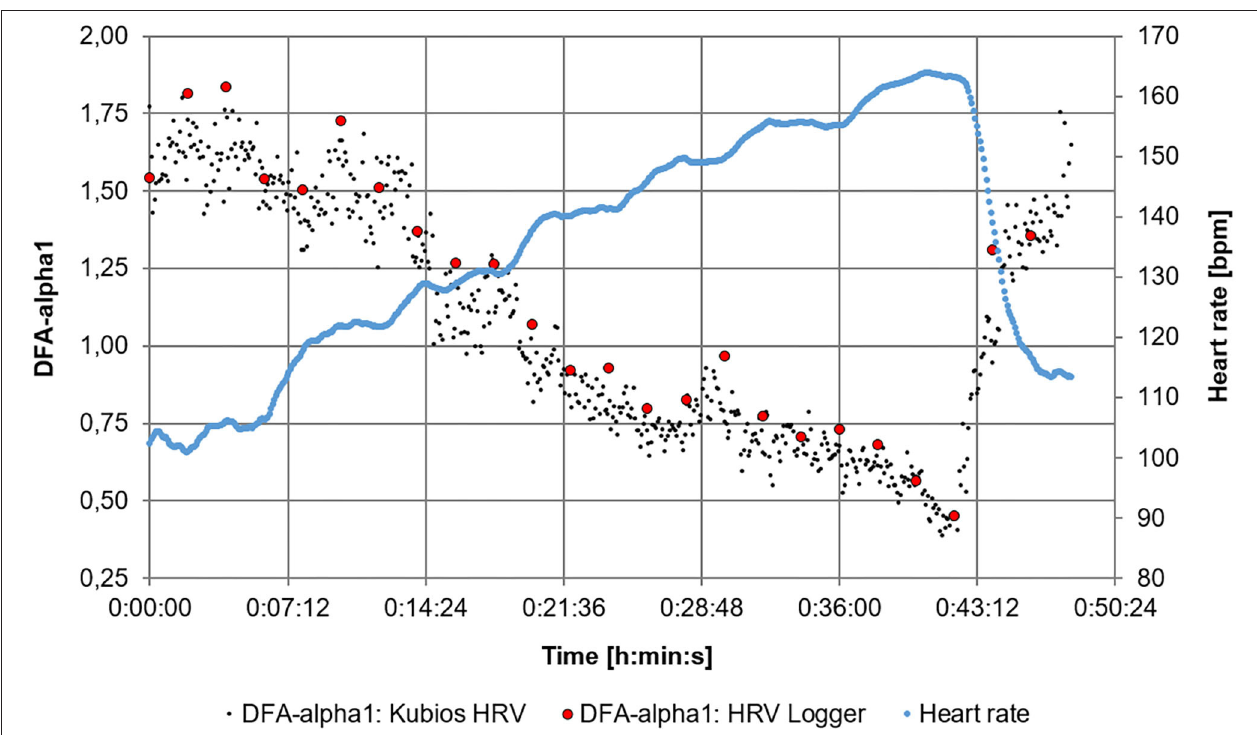
FIGURE 3 | Comparison of DFA-alpha1 of the HRV Logger data export (2min segments non-overlapped) and the raw data evaluation of the Garmin fit. file via Kubios HRV premium software (time-varying method, window width = 2min, grid interval = 5s) throughout the 6 min stage